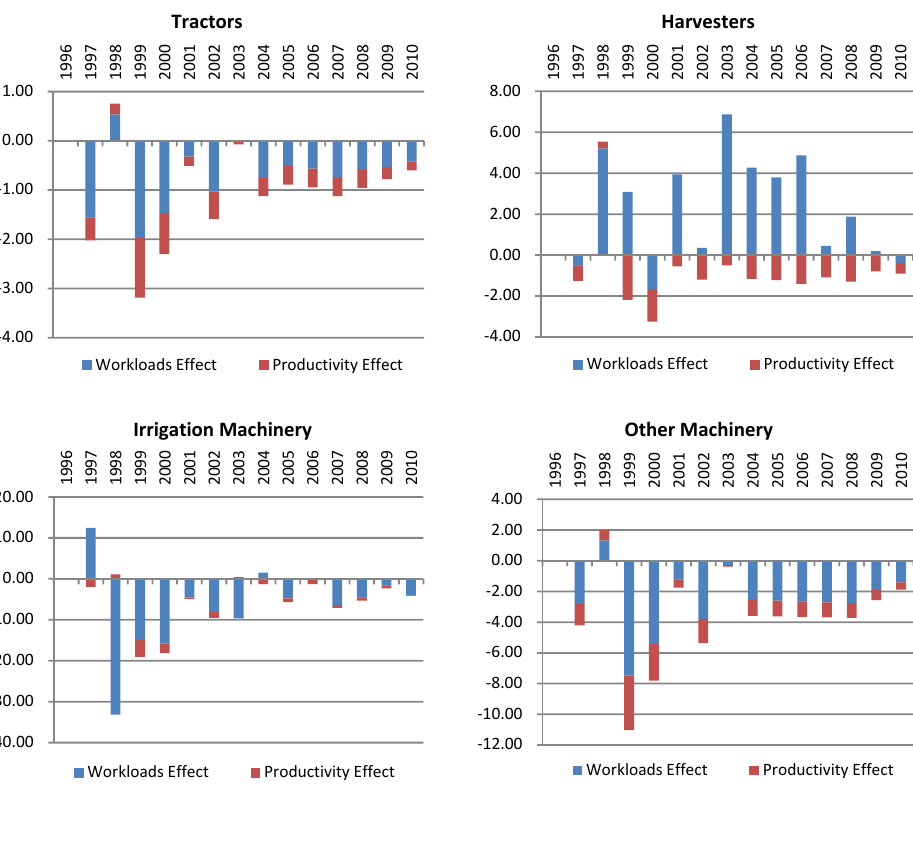
Figure 8. Changes in the annual average working hours compared with that in the previous